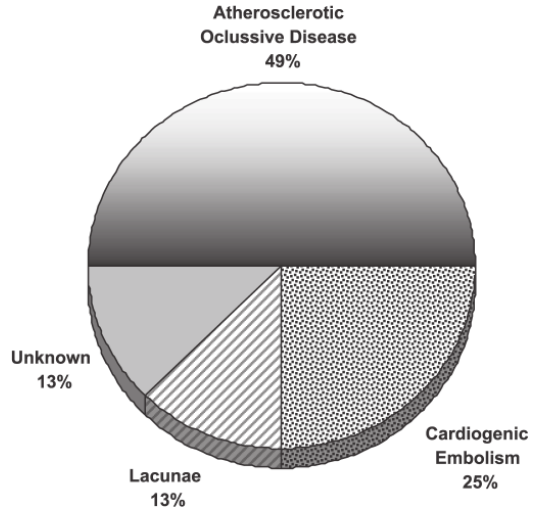
Figure 1 - Causes of Ischemic Stroke in Young People.